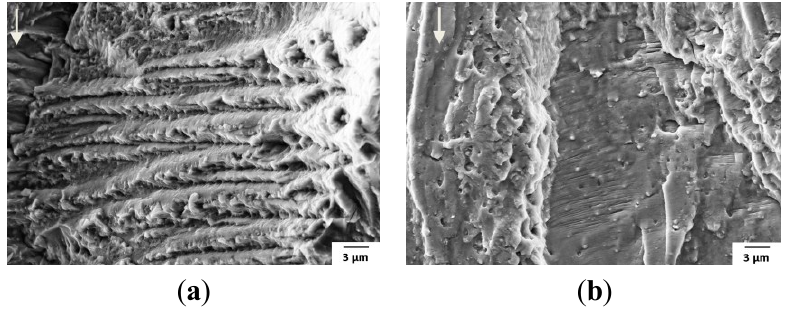
Figure 5. Fatigue crack surfaces of the unreinforced conditions: ( a ) non-ECAP-processed and ( b ) after one ECAP pass near the fatigue threshold. The crack propagation direction is marked with an arrow. The surface of the non-ECAP-processed condition exhibits a band-type faceted appearance, whereas ECAP leads to plateaus and clearly visible striations.